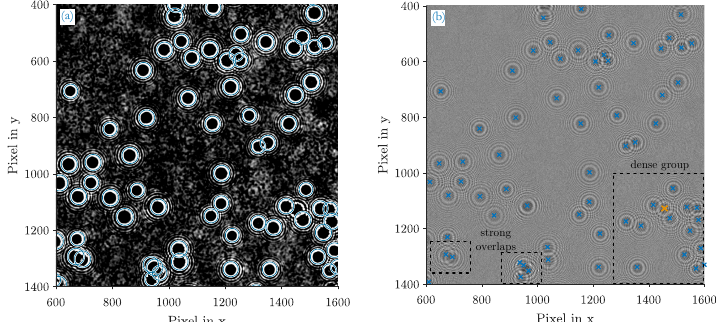
Figure 5. Detection result of the customized HT (selected image section) ( a ) Gaussian filtered fringe patterns ( σ lp = 2.62) where all detected fringes are highlighted with circles; ( b ) the original fringe patterns. Its determined centroids equal the actual position of the particles in the xy - plane. There is one missing hit